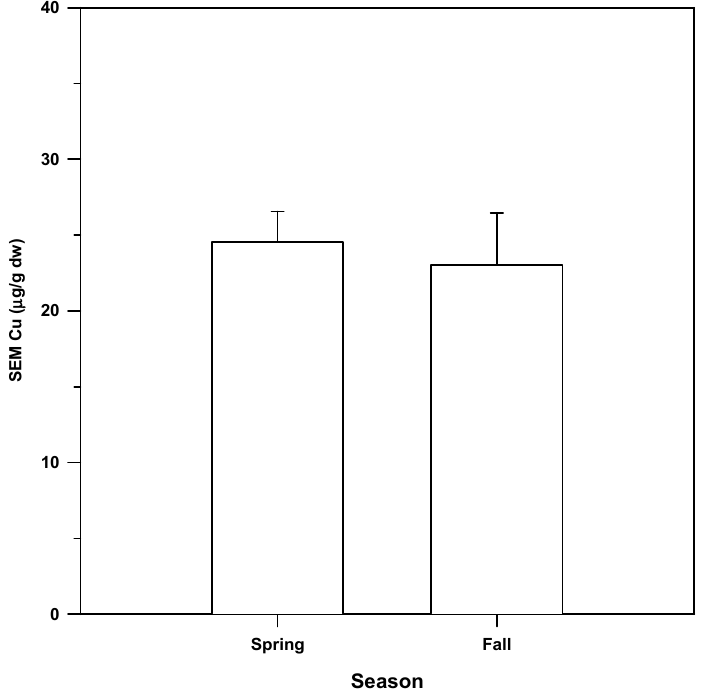
Figure 22. All Cache Slough SEM Cu sediment data for the years 2012–2014 combined by season (Mann-Whitney Rank Sum Test, p = 0.126).